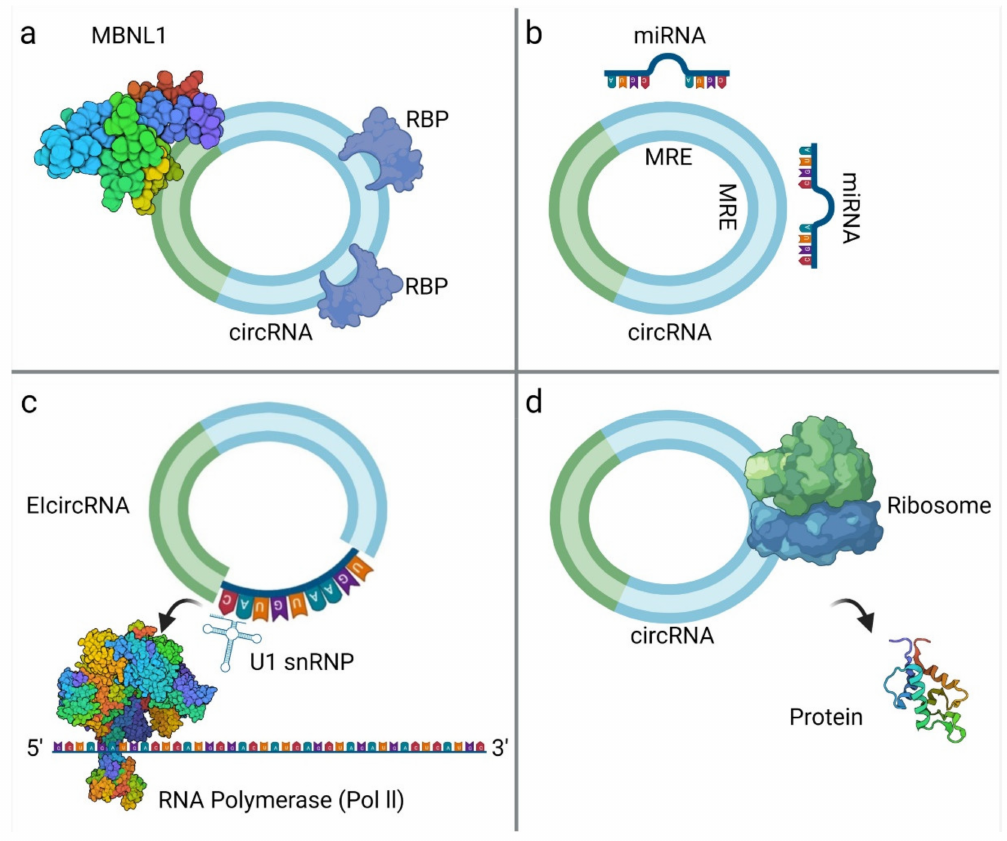
Figure 2. CircRNA interactions: ( a ) CircRNA binds with RNA-Binding Proteins (RBPs), such as MBNL1 [80]; ( b ) circRNAs act as miRNA sponges; ( c ) EIcircRNA interacts with the U1 Small Nuclear Ribonucleoprotein (snRNP) and then binds to RNA Polymerase II (Pol II) [81]; ( d ) circRNA translation into proteins. The surface of the molecules MBNL1 and Pol II are modelled according to van der Waals surface (this illustration was created with BioRender.com, accessed on 3 November